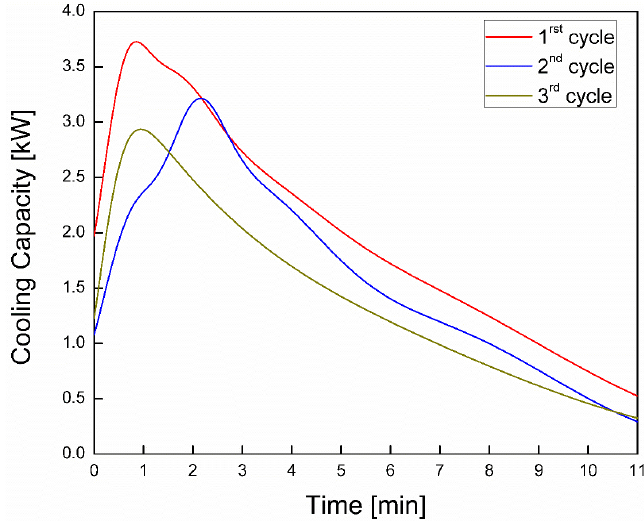
Figure 9. Variation of the cooling capacity during the cycle period.